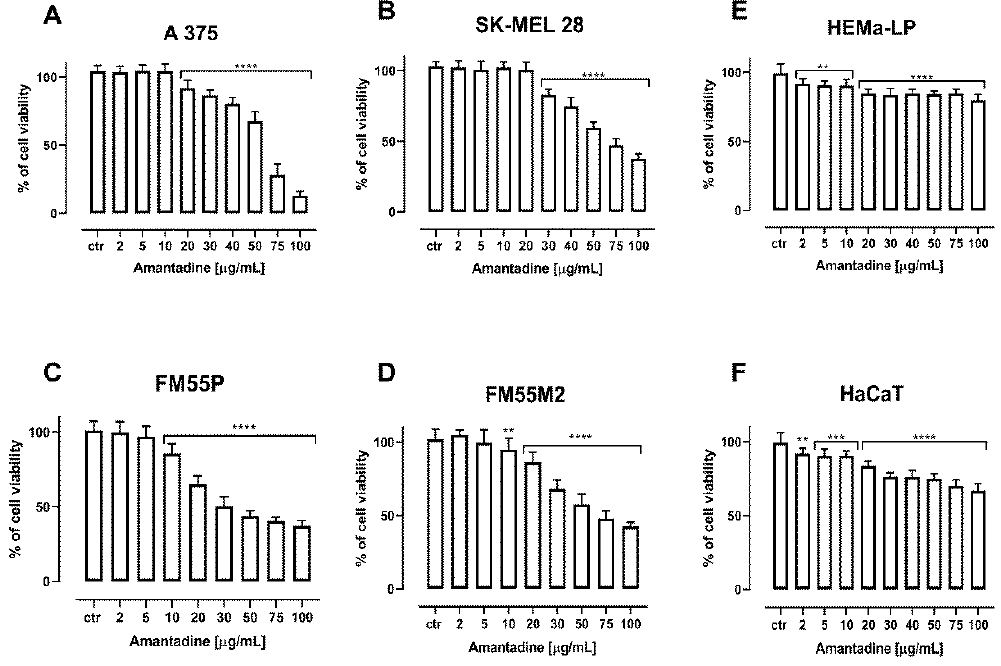
Figure 1. The anti-proliferative effect of amantadine administered against melanoma cell lines (A375 ( A ), SK-MEL28 ( B ), FM55P ( C ), FM55M2 ( D )), melanocytes (HEMa-LP ( E )) and keratinocyte (HaCaT ( F )). Inhibition of cell viability was measured by the MTT assay after 72 h treatment with various increasing concentrations of the amantadine. Results are presented as mean ± SEM. (** p < 0.01; *** p < 0.001: **** p < 0.0001 vs. the respective ctr group).